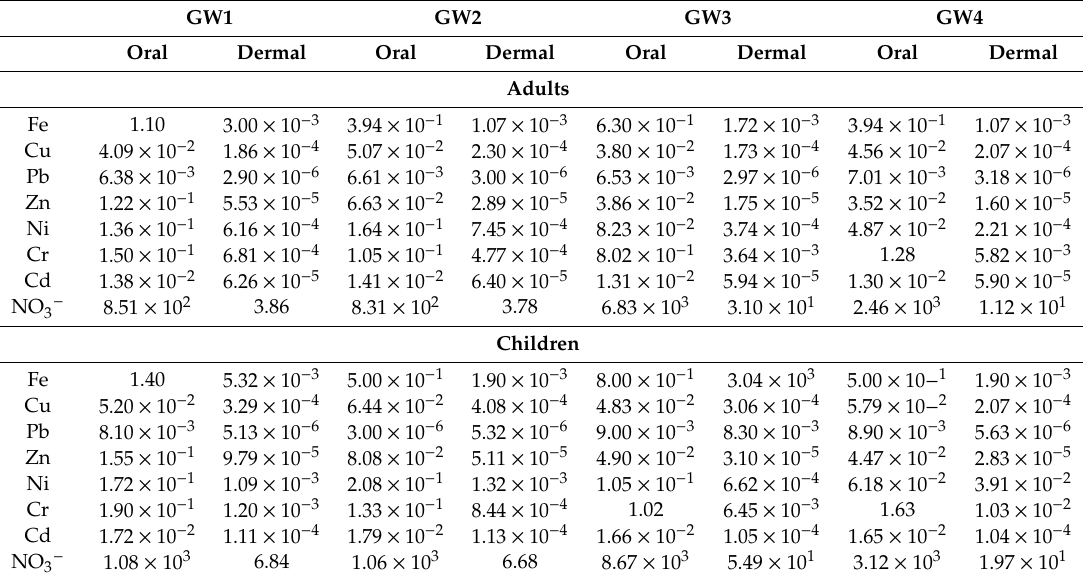
Table 6. Chronic daily intake (CDI, µ g kg − 1 days − 1 ) for adults and children. GW1 GW2 GW3